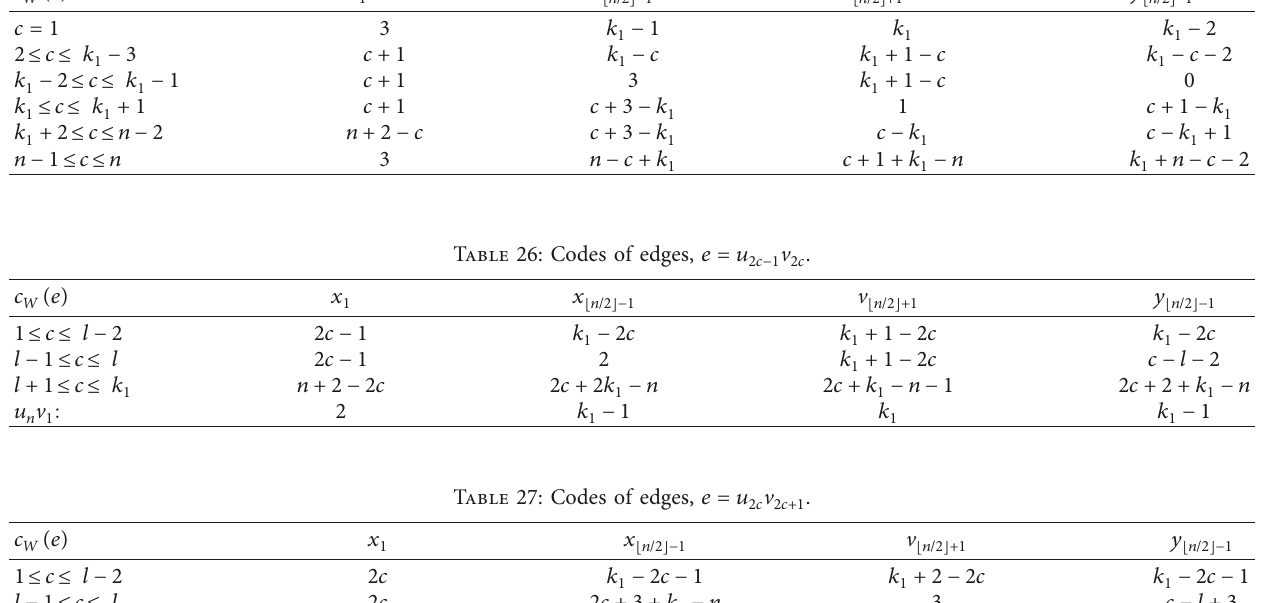
Table 25: Codes of edges, e � y